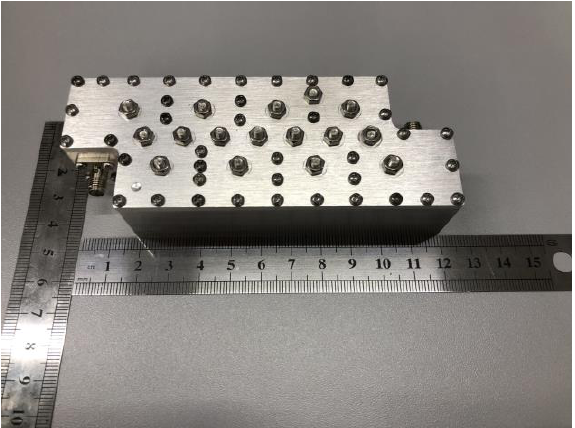
Figure 9. Physical view of the new 2080 MHz capacitive-load cavity-filter processed.